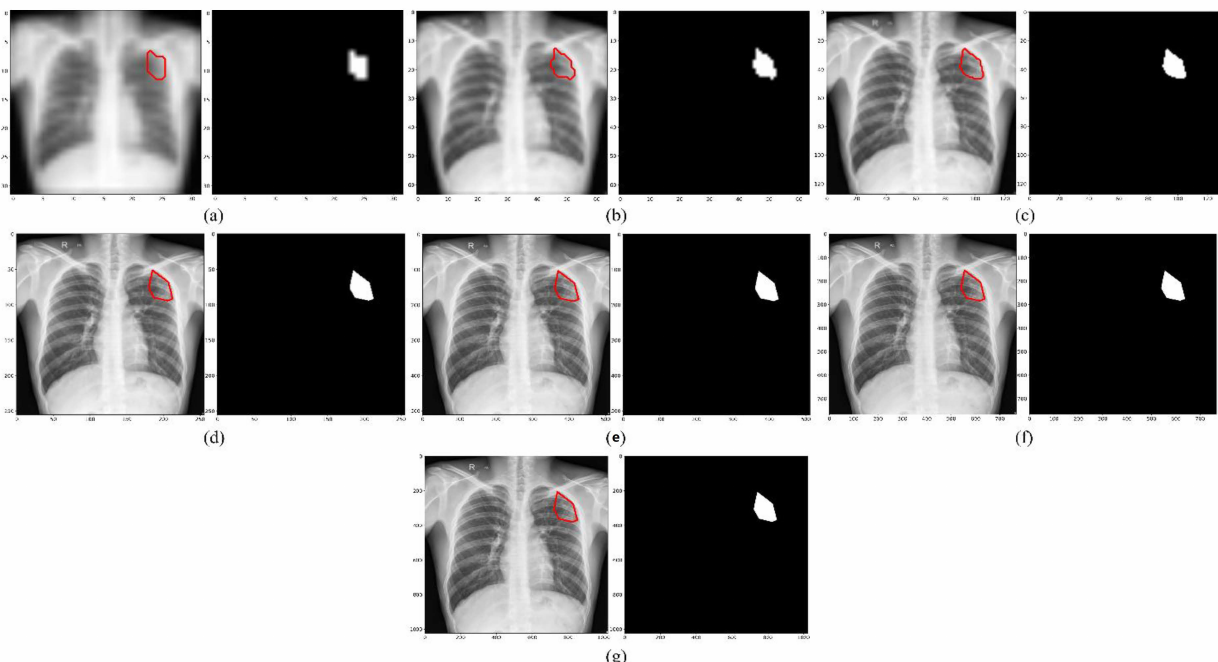
Figure 2. CXRs and their corresponding TB-consistent lesion masks at various image resolutions. ( a ) 32 × 32; ( b ) 64 × 64; ( c ) 128 × 128; ( d ) 256 × 256; ( e ) 512 × 512; ( f ) 768 × 768; and ( g ) 1024 × 1024. All images and masks are rescaled to 256 × 256 to compare quality. The red contours indicate ground truth